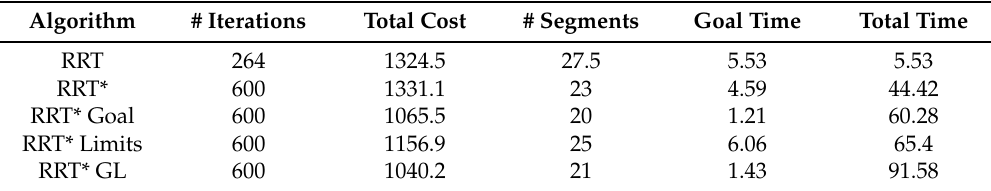
Table 11. Results. Three obstacles, 600 iterations.